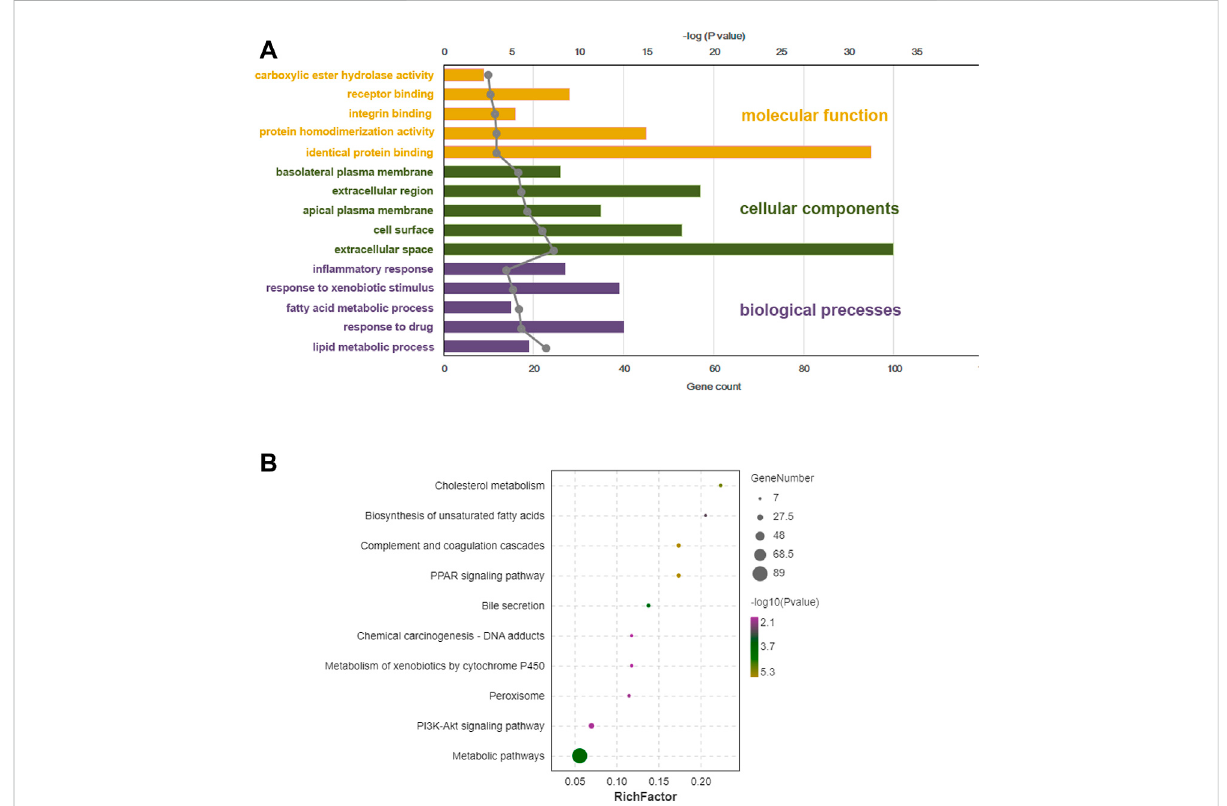
FIGURE 6 BioinformationanalysisofenrichedGO(geneontology)termandKEGG(KyotoEncyclopediaofGenesandGenomes)pathwaysofdifferentially expressed genes from BC-H (high dosage of Bailing Capsule) group vs. DN (diabetic nephropathy) group. (A) Top 5 signi fi cant GO term of DEGs (differentially expressed genes) identi fi ed by transcriptional analysis in each catalogue. (B) KEGG enrichment analysis for DEGs identi fi ed by transcriptomics